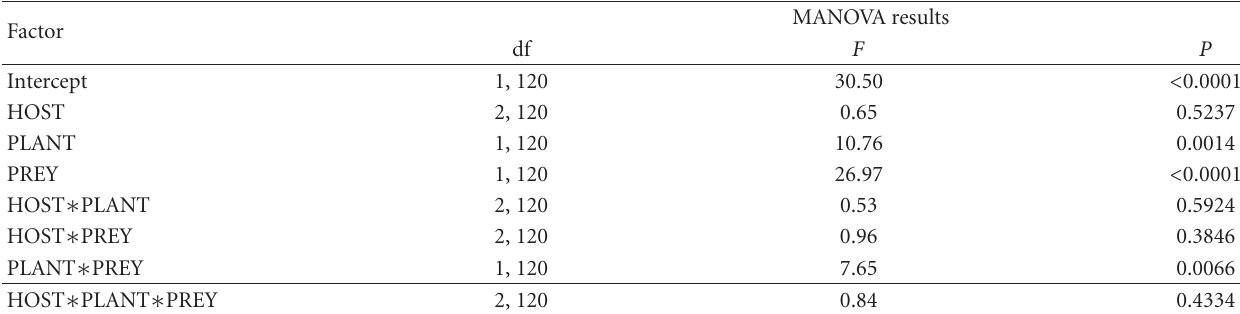
Table 3: Results of a three-factor MANOVA (response = contrast) of time spent in plant feeding and time spent in prey feeding by Dicyphus hesperus